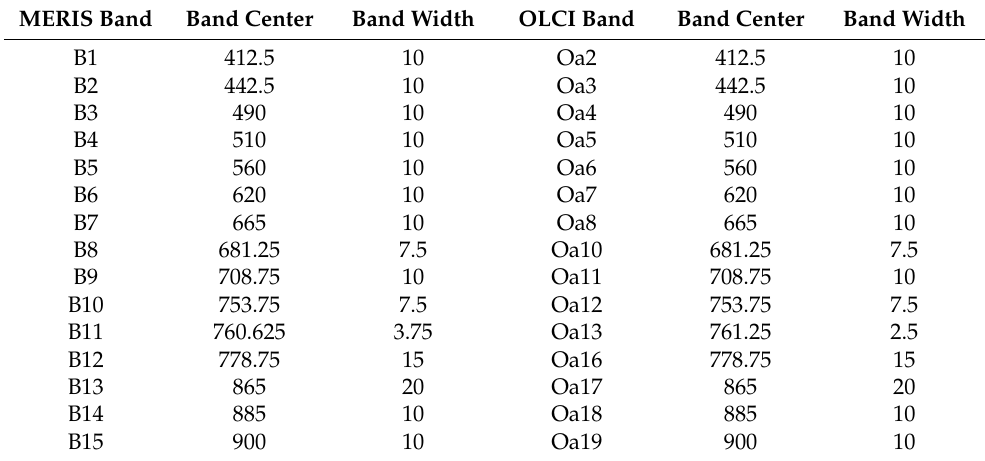
Table 3. Corresponding band settings of the Envisat MERIS and Sentinel-3 OLCI sensors. MERIS